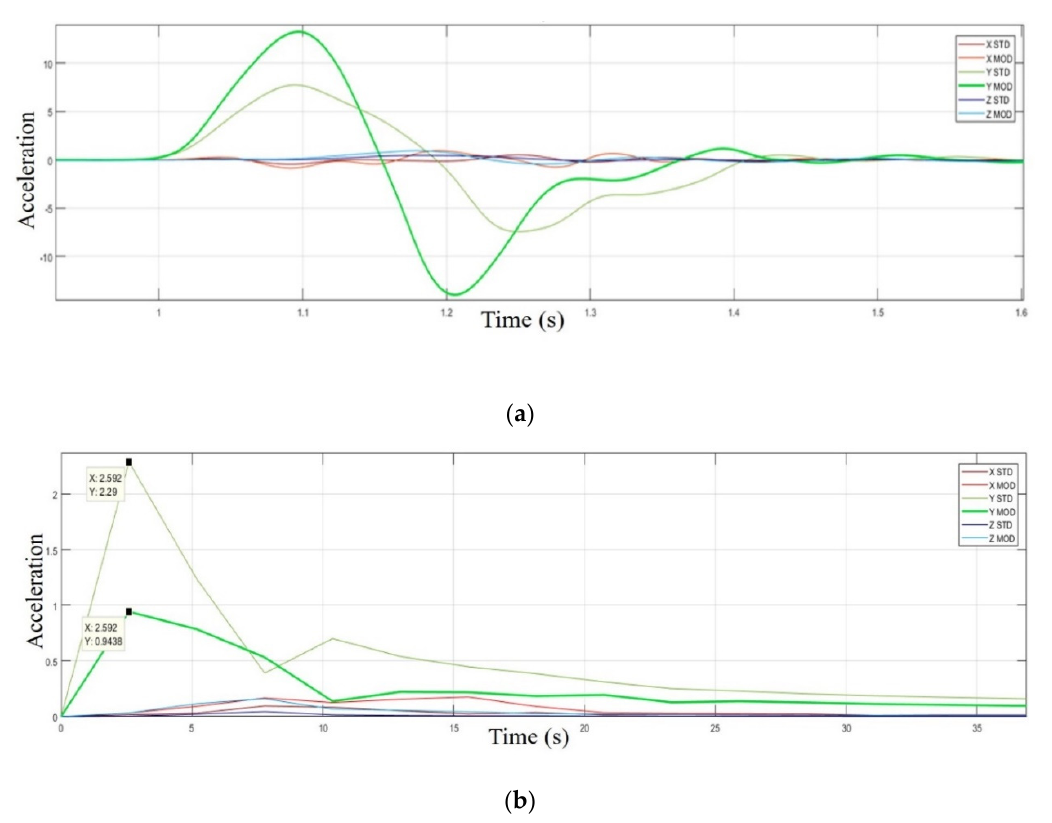
Figure 10. Experimental results of a move run according to the new planning strategy: acceleration profile with respect to time ( a ) and frequency ( b ).